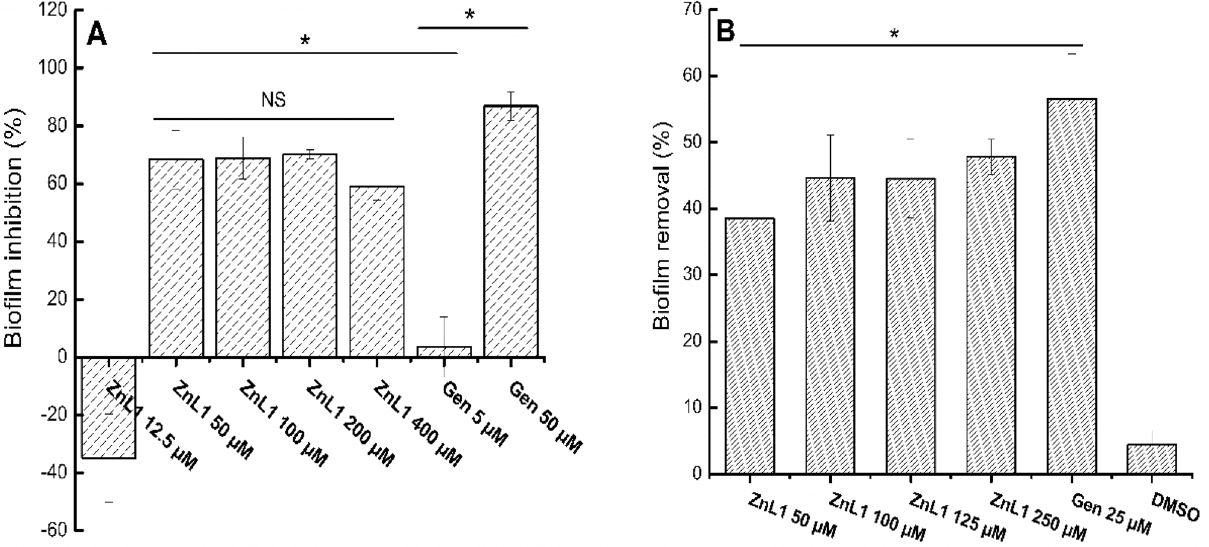
Figure 4. Effects of ZnL1 in comparison with Gen, on forming and preformed biofilms of A. baumannii . ( A ) Effects on forming biofilm–biofilm inhibition ( B ) Effects on pre-formed biofilm–biofilm removal. Error bars represent SD of at least three independent replicates. NS not significant, * significant difference between marked experimental conditions ( p < 0.05) according to ANOVA followed by Tukey’s test (Table S3 (A and